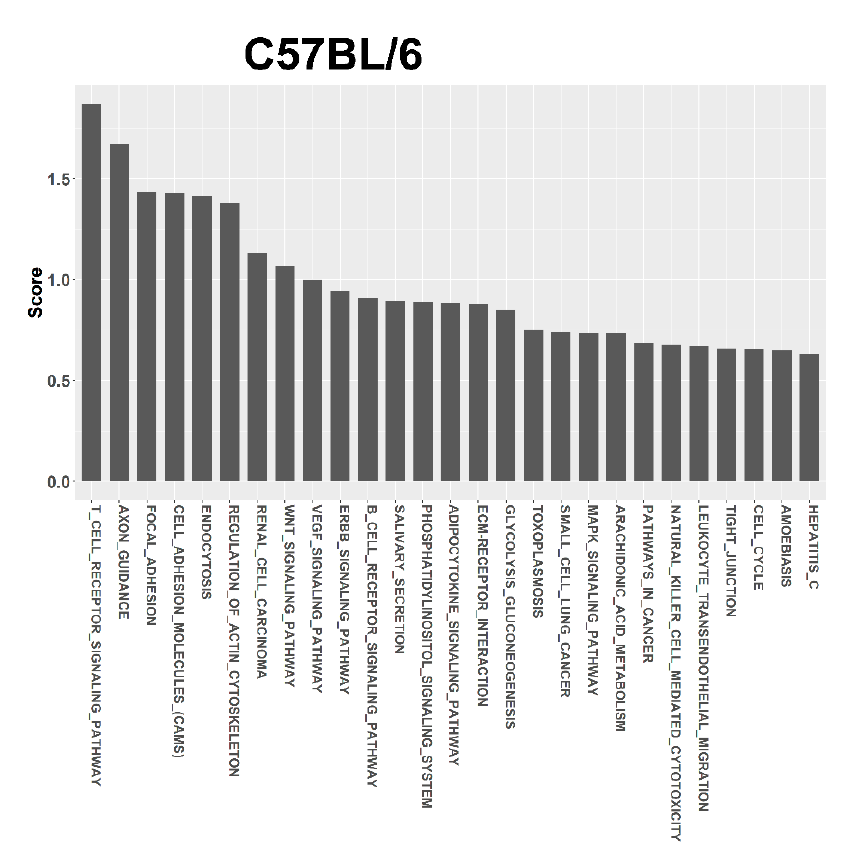
Figure 5. Pathway ranking summery of the genes by the dysregulated miRNAs from miRSystem database during weight reduction in C57BL/6 mice. These pathways were annotated according to KEGG.